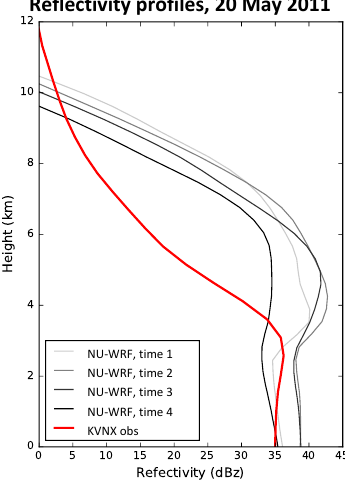
Figure 17. Reflectivity profiles obtained from the 1h average of reflectivity time series shown in Fig. 16 from KVNX (red line) and AERO simulation times 1, 2, 3, and 4 indicated in Fig. 16 (light to dark grey lines).